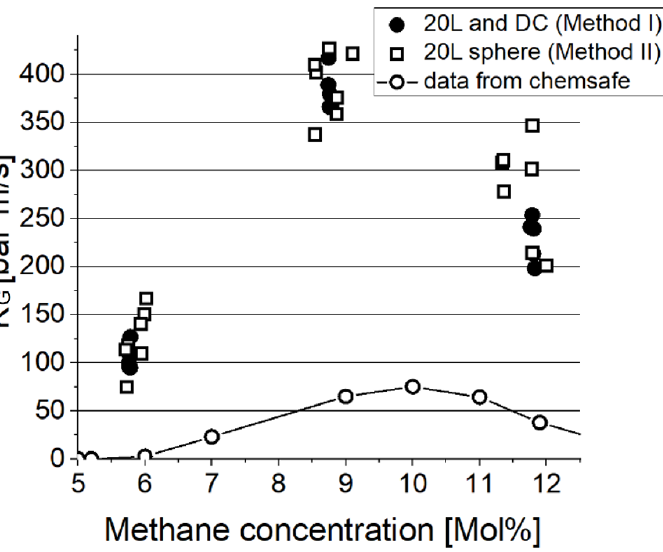
Figure 6. K-values of methane; two different mixing procedures: flammable gas inside the 20 L-sphere only and premixture in the 20 L-sphere and the dust container (DC).